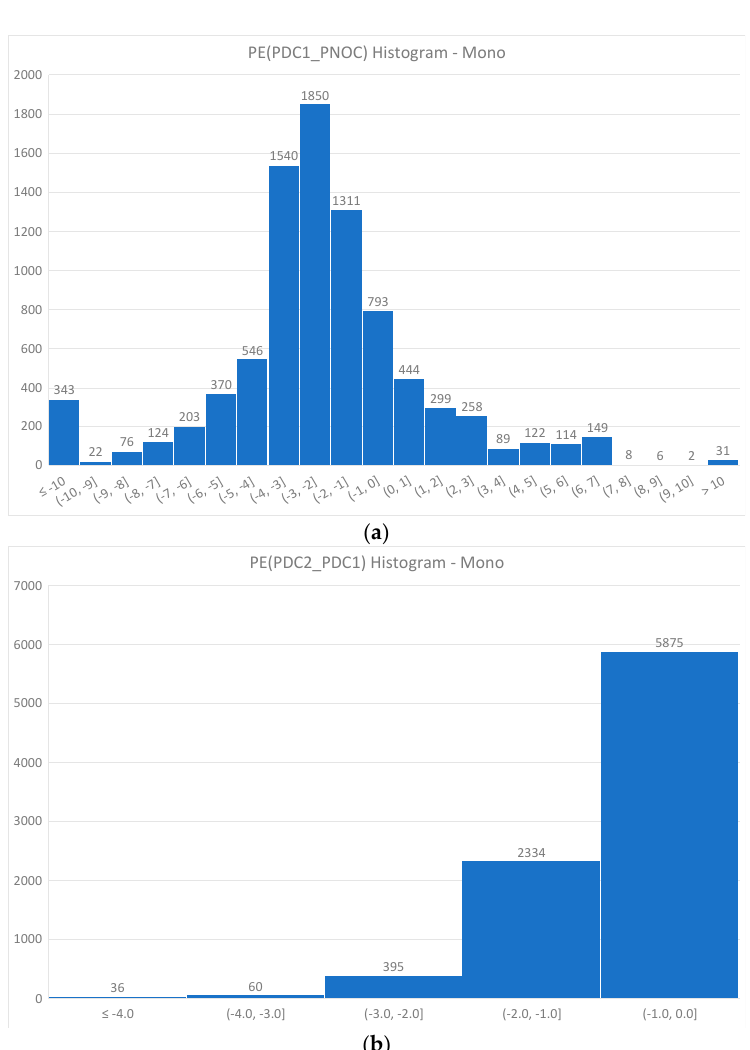
Figure 4. Histograms of the Percentage Error 𝑃𝐸 (cid:2869)(cid:3015)(cid:3016)(cid:3004) concerning 𝑃𝐷𝐶 (cid:2869)(cid:3015)(cid:3016)(cid:3004) and 𝑃 (cid:3015)(cid:3016)(cid:3004) ( a ), and the Percentage Error 𝑃𝐸 (cid:2870)(cid:3015)(cid:3016)(cid:3004) concerning 𝑃𝐷𝐶 (cid:2870)(cid:3015)(cid:3016)(cid:3004) and 𝑃𝐷𝐶 (cid:2869)(cid:3015)(cid:3016)(cid:3004) ( b ); monocrystalline modules.